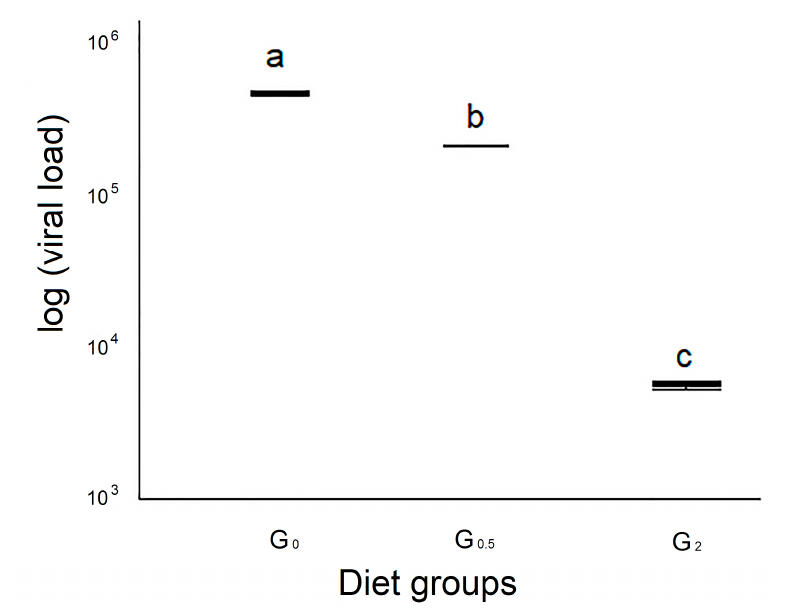
Figure 3. Viral load in the whole bee samples. In G 0 , G 0.5 , and G 2 , are grouped bees fed with 0%, 0.5%, and 2% of 1,3-1,6 β -glucans (w/w) in syrup, respectively. Values were expressed as exponential function. Different letters show statistically significant differences ( p < 0.05).